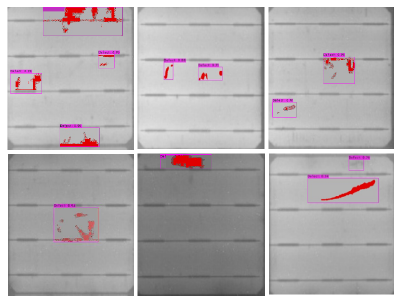
colors are shown in Figure 3.